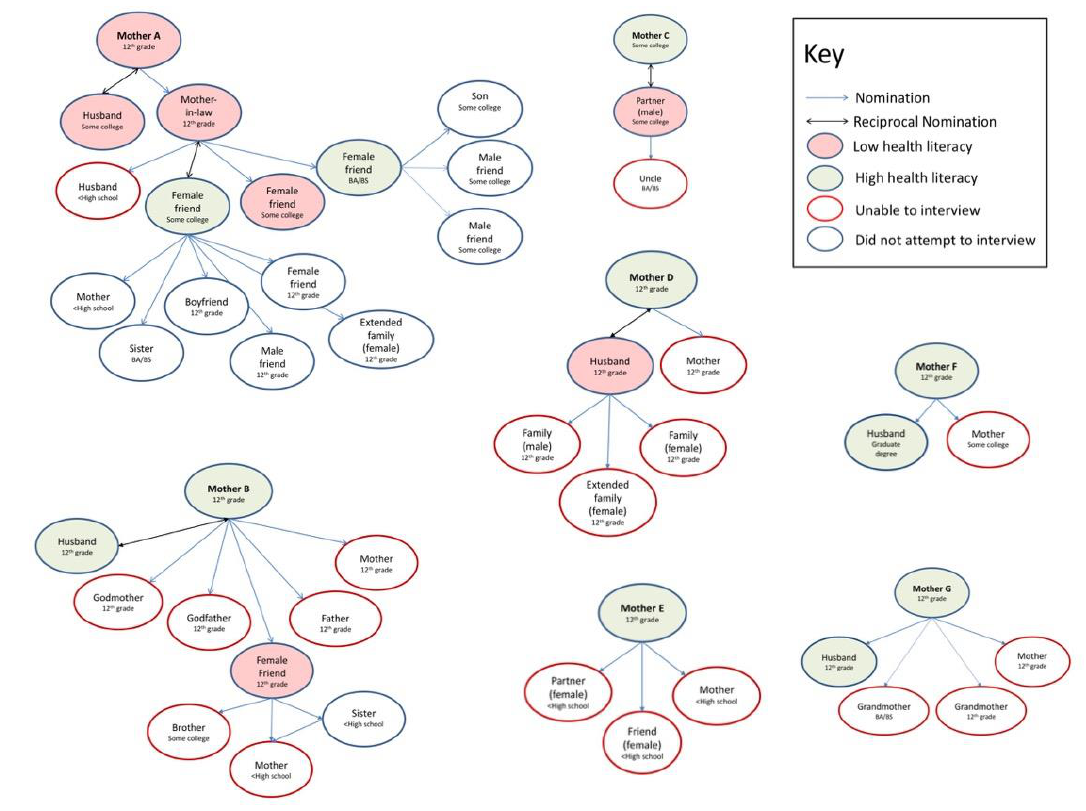
Figure 1. Egocentric health information structure of the seven focal moms (“egos”). Those we were able to interview have self-reported health literacy filled in. Self-reported low health literacy (LHL) is indicated by pink fill and high / adequate by grey. Those we tried but could not interview are outlined in red. Those who were not able to be interviewed according to the study protocol are outlined in blue.